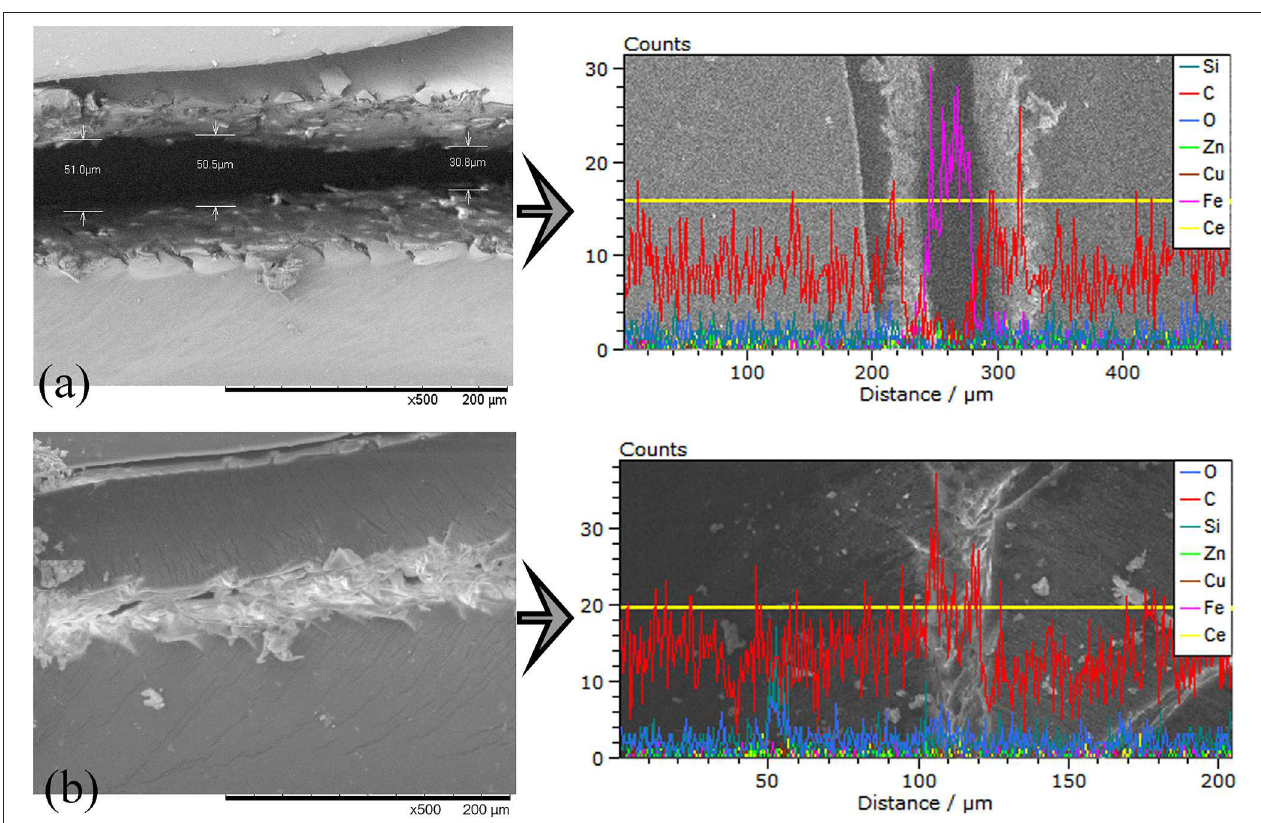
FIGURE 12 | SEM surface images and line elemental analysis of the scribed Epoxy-CSmc coatings (a) before and (b) after thermal treatment at 90 ◦ C for 30min along with the line elemental EDS analysis of the main chemical elements of the metallic substrate (Fe, Zn) and the coating.